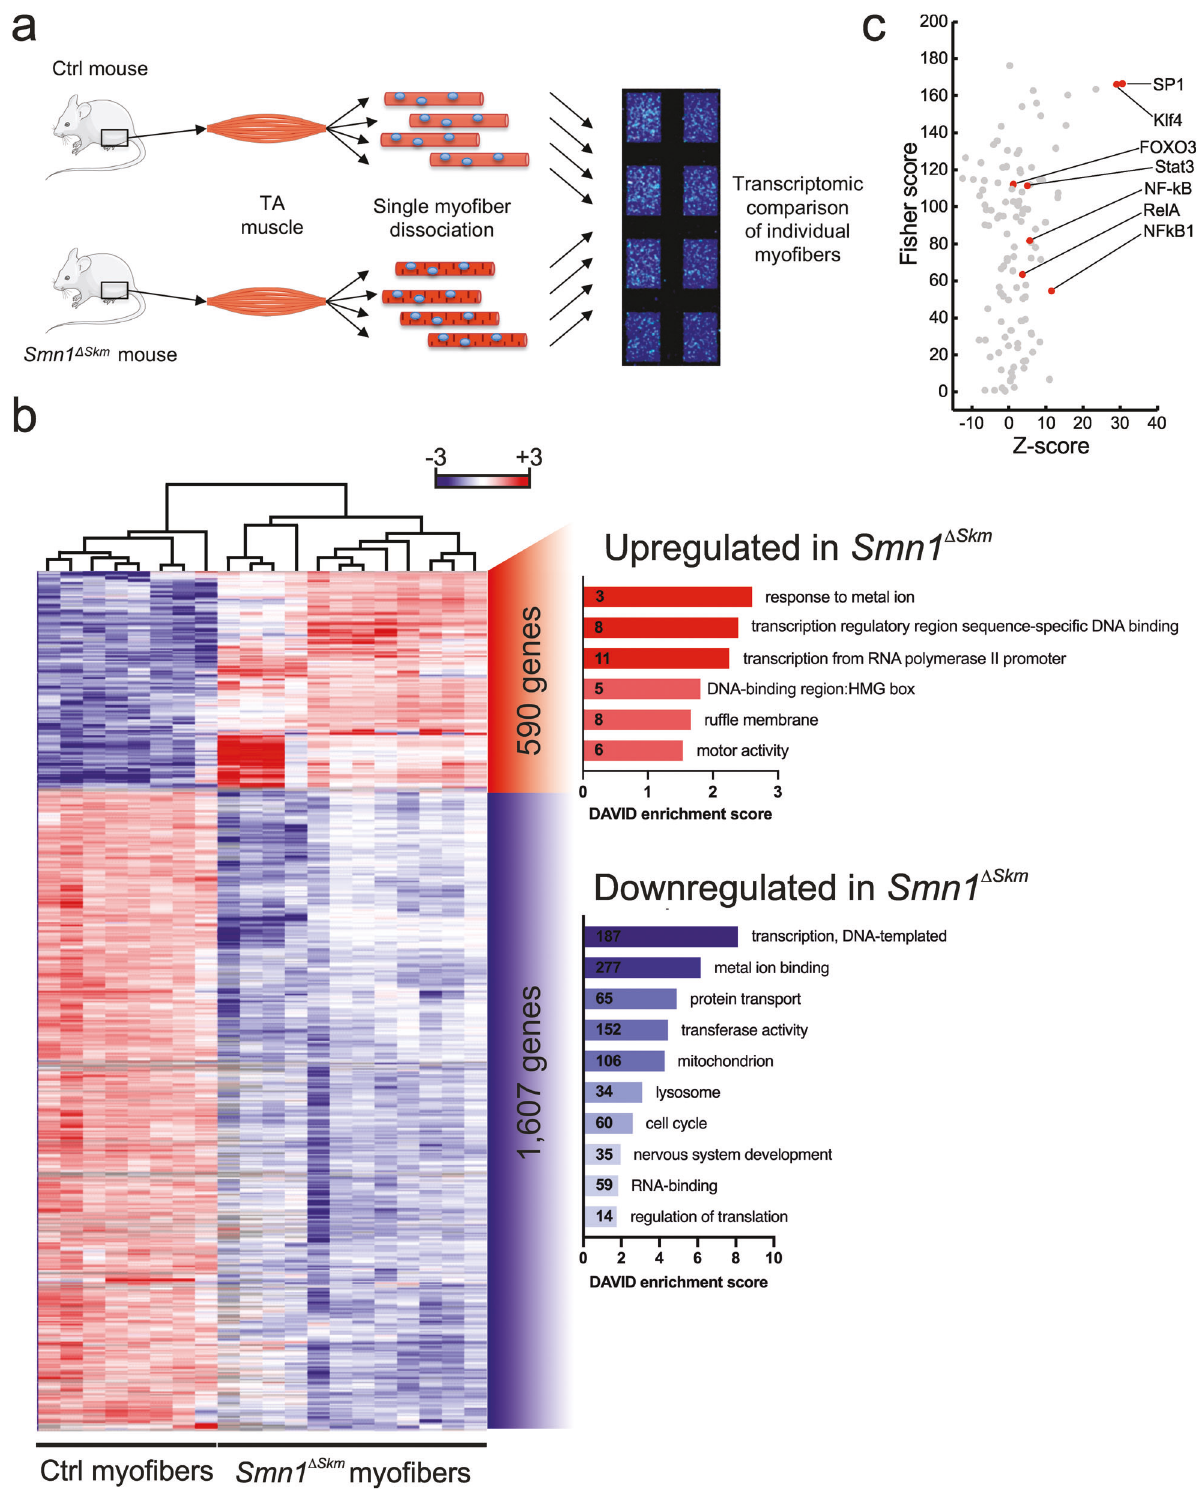
Fig. 1 Single myo fi ber gene signatures reveal the transcriptional changes induced by SMN loss in skeletal muscle. a Schematic representation of the experimental steps leading to microarrays of cDNA produced from RNA extracted from single myo fi bers of the indicated genotypes. b Cluster analysis of the differentially expressed genes (DEGs) distinguishes the signatures of myo fi bers isolated from tibialis anterior muscles of Wt and Smn1 Δ Skm mice. Gene ontology (GO) analysis of over-and under-expressed genes in response to SMN loss. Enrichment score by DAVID was used to rank the annotation groups. The numbers inside bars correspond to the number of DEGs in each cluster. c Plot of the Fisher score (y-axis) vs. the Z-score (x-axis) from the oPOSSUM transcription factor enrichment analysis of the list of DEGs in b . Each transcription factor is represented by a dot on the graph; transcription factors whose binding sites are most strongly enriched within the promoters of the speci fi ed gene list have high scores (top right of plot).